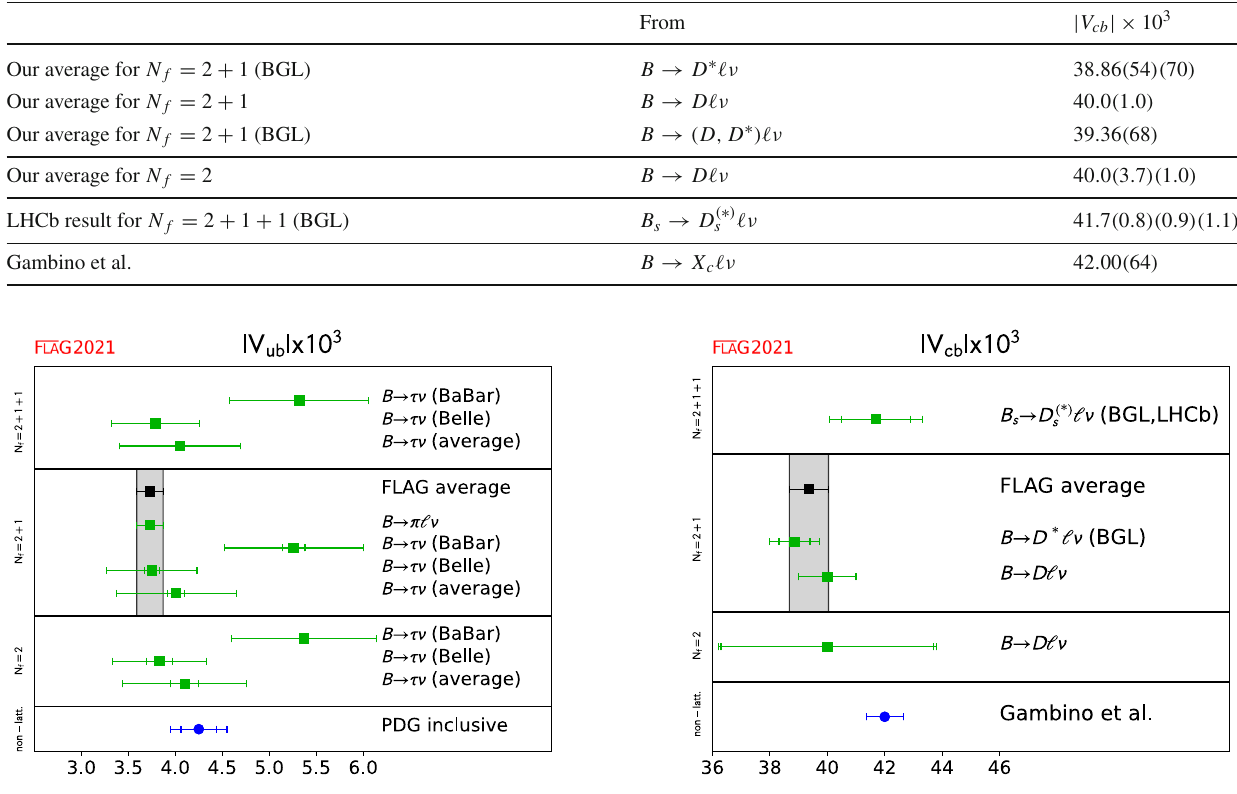
Table 59 Results for | V cb | . When two errors are quoted in our averages, the first one comes from the lattice form factor, and the second from the experimental measurement. The LHCb result using B s → D